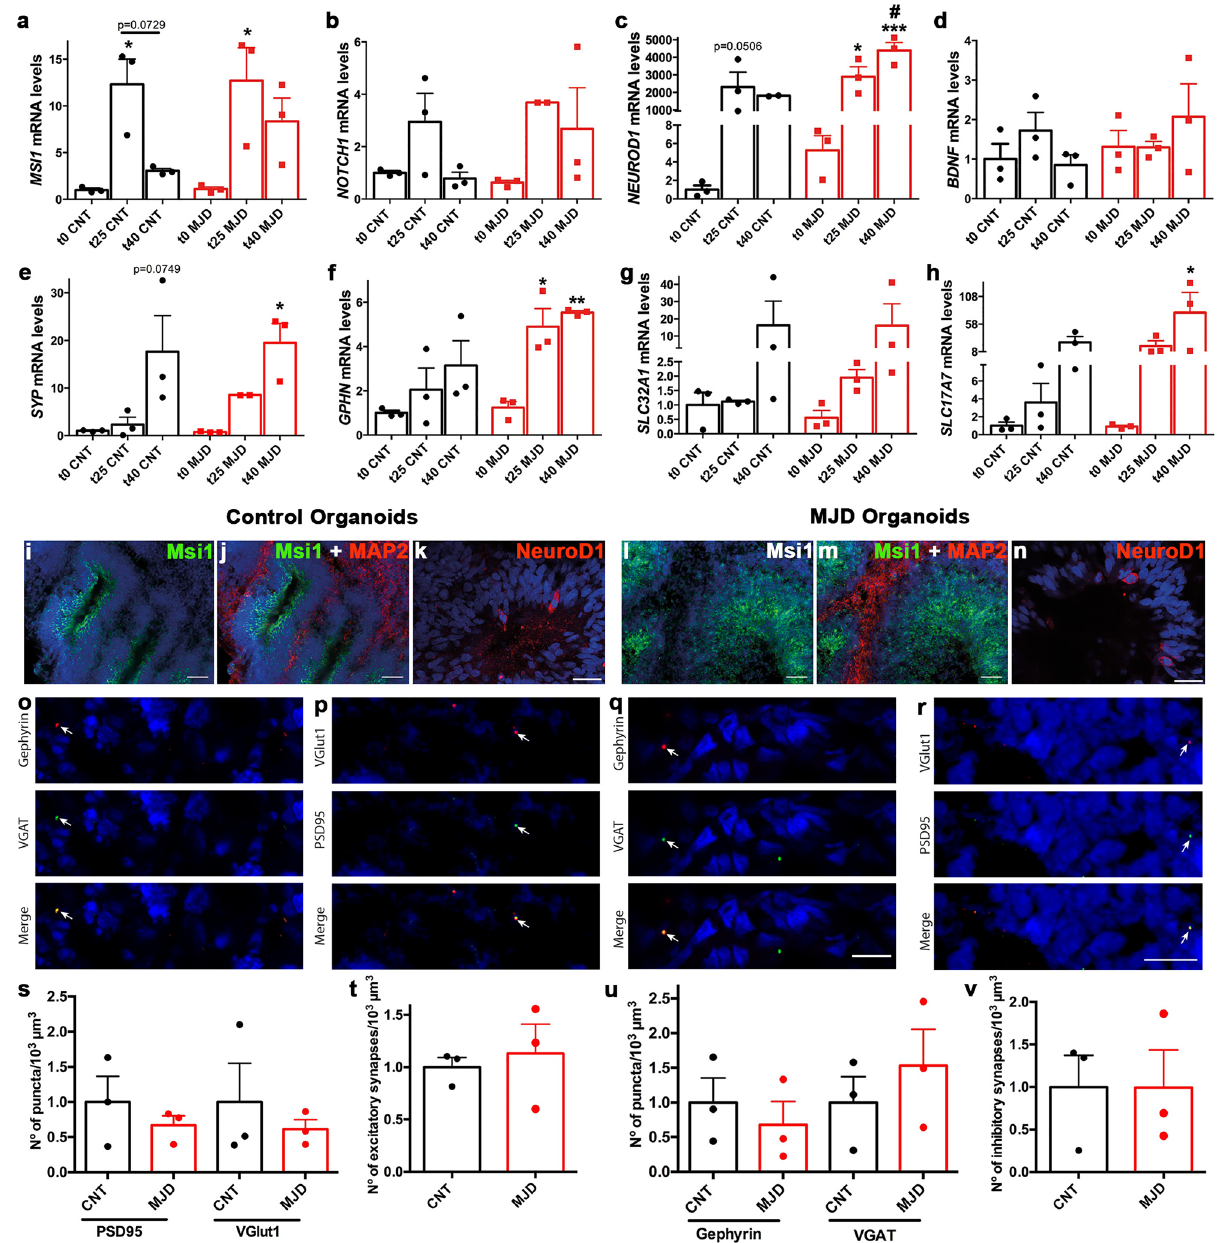
Figure 2. Control and MJD brain organoids present markers of neural progenitors proliferation, neuronal differentiation, and synaptic function. (a–h) Control and MJD organoids at different time points (day 0, 25, and 40; t0, t25, and t40 respectively) evaluated for neural progenitors proliferation markers (a) MSI1 and (b) NOTCH1 , neuronal differentiation marker (c) NEUROD1 , brain- derived neurotrophic factor (d) BDNF , and the synaptic markers (e) Synaptophysin ( SYP ), (f) Gephyrin ( GPHN ), (g) GABA vesicular transporter (VGAT, SLC32A1 ), and (h) vesicular glutamate transporter 1 (VGlut1, SLC17A7 ) mRNA levels, through RT-qPCR and normalized for t0 CNT. Data indicated an increase of neural progenitors proliferation and neuronal differentiation at day 25 and of synaptic markers at day 40. Immunohistochemistry evaluation of CNT and MJD organoids with 40/50 days for (i,j,l,m) Msi1 and (k,n) NeuroD1, showing the presence of these markers mainly in the ventricular-like zones, whereas (j,m) MAP2 is mainly surrounding these zones. Immunohistochemistry evaluation of (o,q) inhibitory synapses given by the confocal microscopy colocalization between Gephyrin and VGAT positive puncta and (p,r) excitatory synapses indicated by the confocal microscopy colocalization between VGlut1 and PSD95 (postsynaptic density protein 95) positive puncta presence in Control and MJD organoids, demonstrating the presence of inhibitory and excitatory synapses in Control and MJD organoids; white arrows indicate the synapses. Number of (s) PSD95 and VGlut1 puncta, (t) excitatory synapses, (u) Gephyrin and VGAT puncta, and (v) inhibitory synapses per organoid volume (1000 μm 3 ) normalized for the control organoids. DAPI: blue, representative images of 3 independent experiments, scale bars: 50